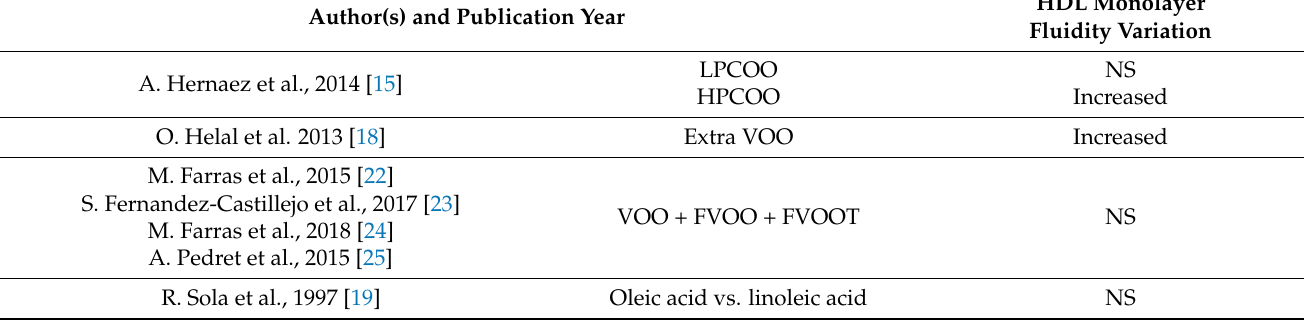
Table 5. High-density lipoprotein (HDL) monolayer